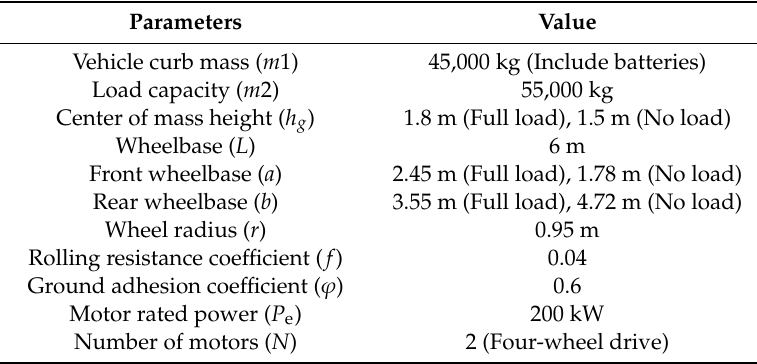
Table 1. Main parameters of mining